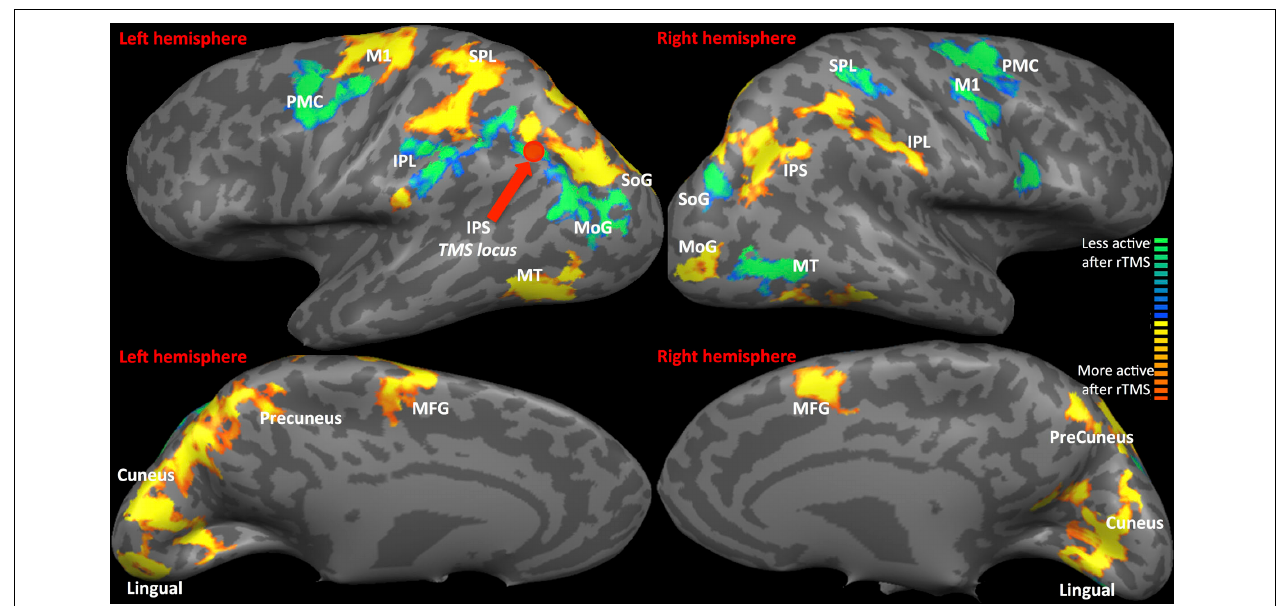
FIGURE 2 | fMRI-Regions of interest analysis (ROIs) identified from Multi-Subject Fixed Effects GLM analysis. FMRI Activation Maps displaying results of Multi-subject fixed effects GLM with comparisons between pooled runs (1, 2, and 3) of rTMS vs. sham.